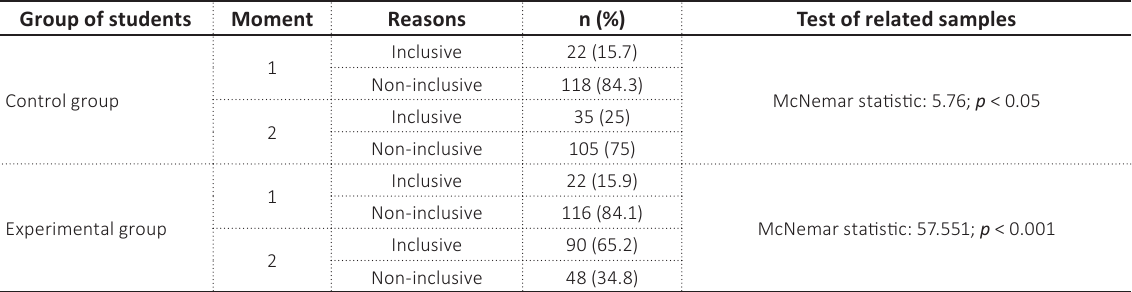
Table 3. Questionnaire trial 2: Results of what the students like less in non-inclusive ad Group of students